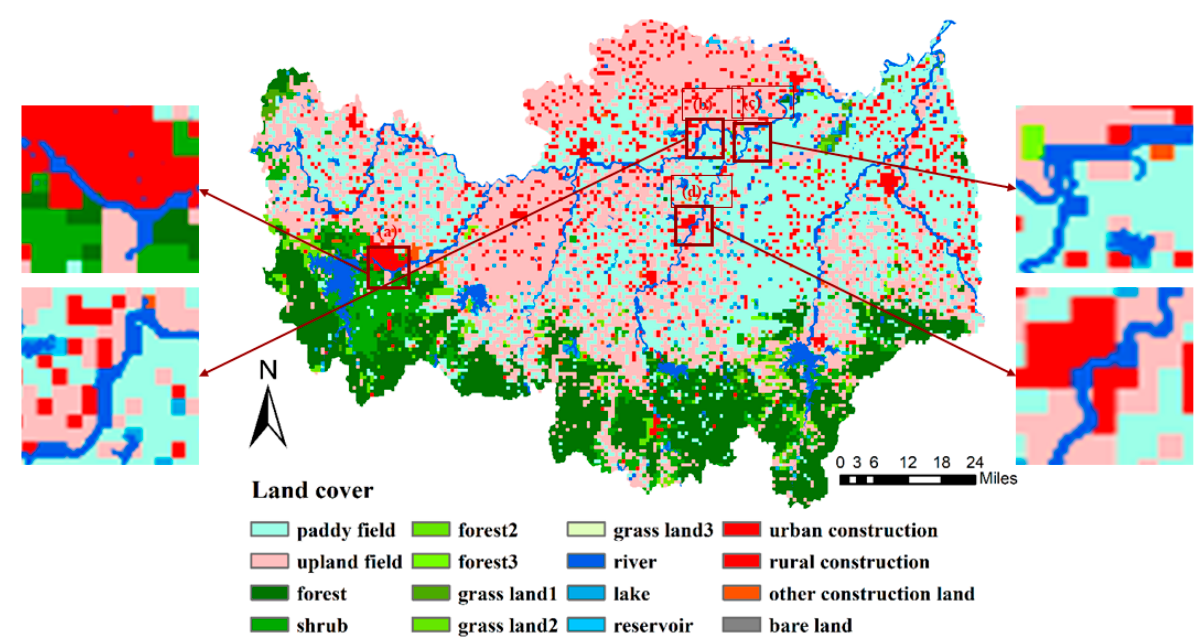
Figure 10. 1 km Land Use Classification Map of Xinyang City in 2017.